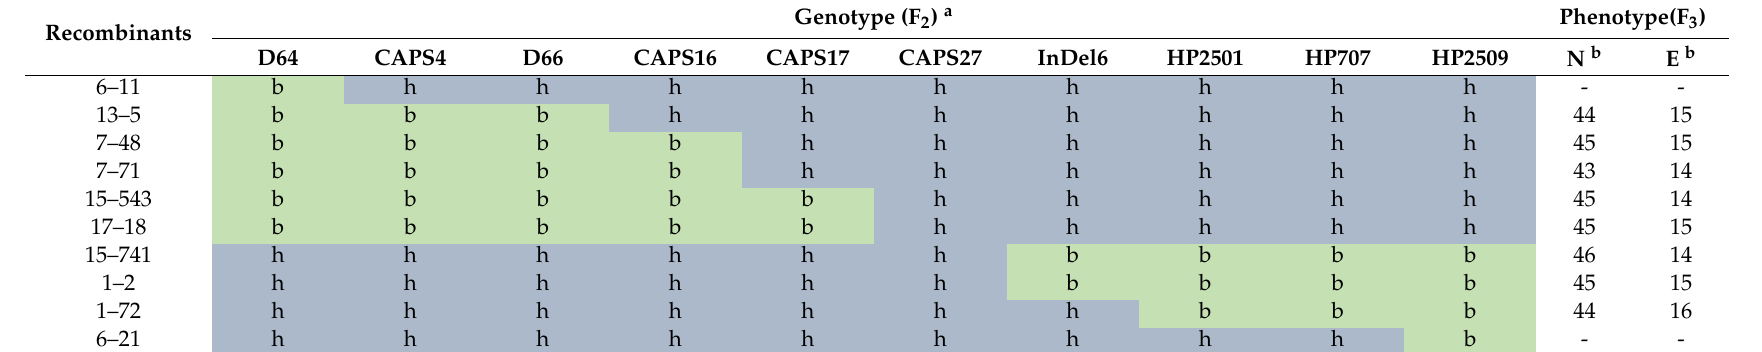
Table 2. Genotypes of F 2 recombinants and phenotypes of F 2:3